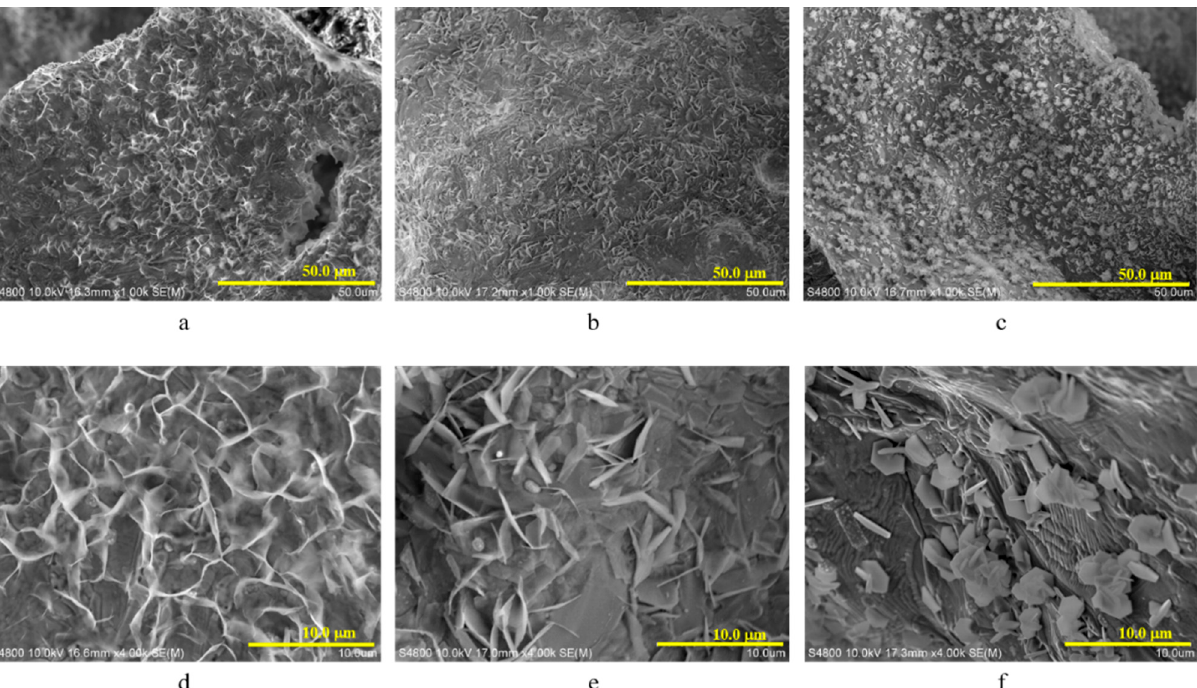
Figure 3. High magnification SEM images of the internal pore structure of sintered 440C stainless steel samples after zinc electrodeposition. The amount of NaCl is 30 wt% in all images. The electrolytes used in the electrodeposition process are zinc acetate ( a , d ), zinc sulfate ( b , e ), and zinc chloride ( c , f ).